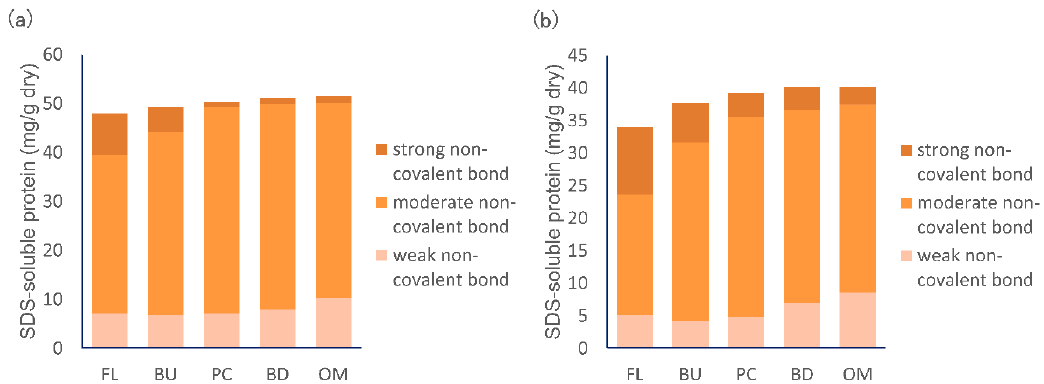
Figure 8. Changes in the amount of protein aggregated through various strengths of non-covalent bonds in high protein flour ( a , HF) and in low protein flour ( b , LF) during mixing. FL, BU, PC, BD, and OM indicate flour (before mixing), build up, peak consistency, breakdown, and overmixing, respectively. The amount of protein aggregated through strong non-covalent bonds = “the average ( n = 6) of protein aggregates extracted with 0.5% SDS buffer” – “the average amount ( n = 6) of protein aggregates extracted with 0.3% SDS buffer”, moderate non-covalent bond = “the average amount ( n = 6) of protein aggregates extracted with 0.3% SDS buffer” – “the average amount ( n = 6) of protein aggregates extracted with 0.1% SDS buffer”, weak non-covalent bond= “the average amount ( n = 6) of protein aggregates extracted with 0.1% SDS buffer”.